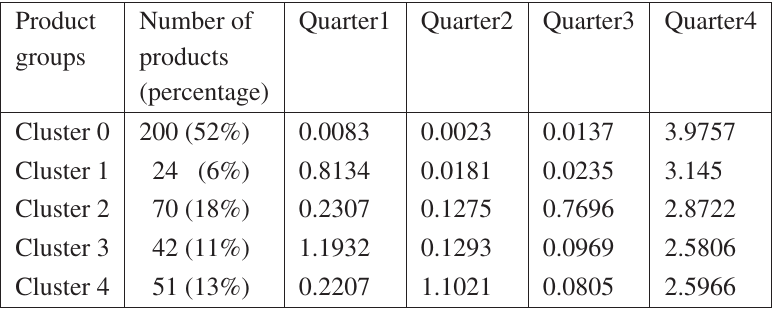
Table 14. Tier-2 2006 quarterly seasonality analysis – Cluster